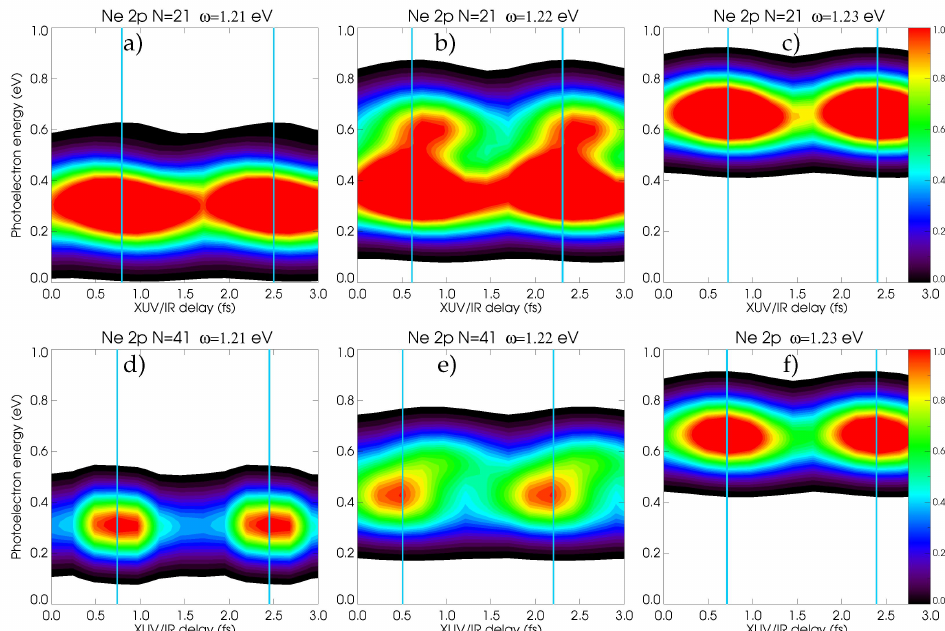
Figure 4. From left to right: RABBITT traces of the Ne atom at the photon frequencies ω = 1.21 ( a,d ), 1.22 ( b,e ), and 1.23 eV ( c,f ). The number of the pulselets N = 21 in the top row ( a – c ) corresponds to the spectral width FWHM = 0.2 eV. In the bottom row ( d – f ), N = 41 and FWHM = 0.1 eV. The thin blue lines mark the center of the SB18.